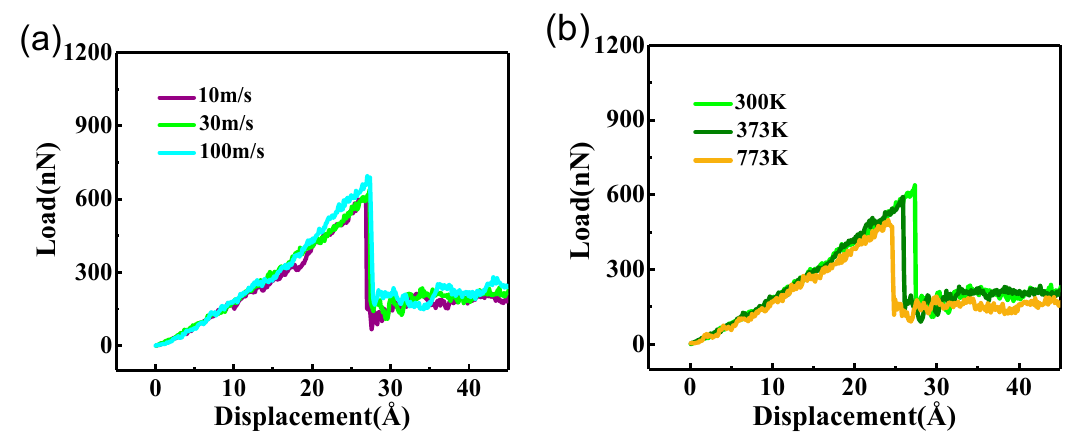
Figure 4. ( a ) Load-displacement curves of composite with monolayer graphene on surface in different loading speeds; ( b ) load-displacement curves of composite with monolayer graphene on surface at different temperatures.